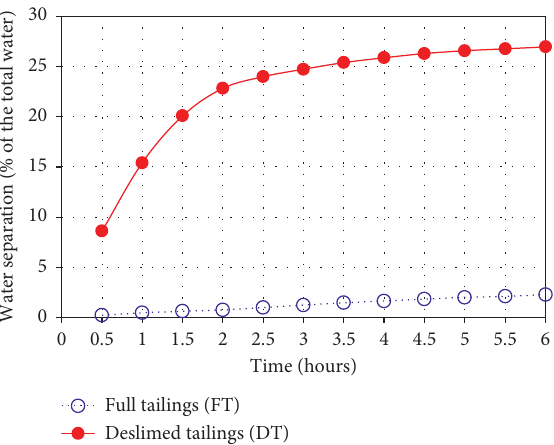
Figure 2: Water-retention characteristics of the